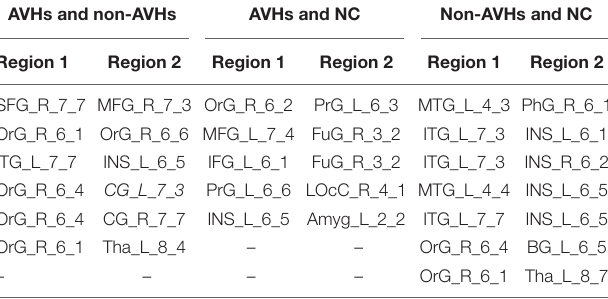
TABLE 5 | Significant differences in variances of the dynamic functional connectivity matrices obtained without regressing out global signal (overlap = 0.9). AVHs and non-AVHs AVHs and NC Non-AVHs and NC Region 1 Region 2 Region 1 Region 2 Region 1 Region